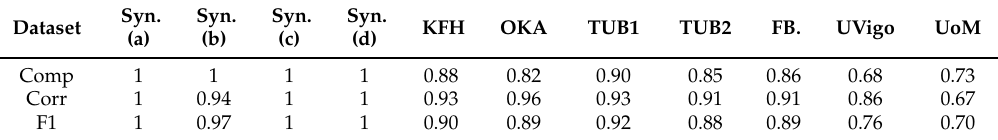
Table 2. Completeness (Comp), correctness (Corr) and F1 score of the reconstruction results.